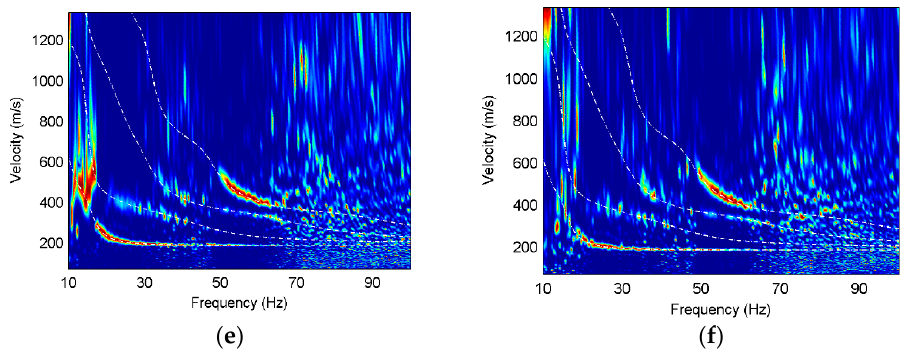
Figure 8. Dispersion images of noisy data of Model 1, where the white dashed lines are the theoretical dispersion curves and the red color represents the maximum energy. SNR of the left column is 2.8 and SNR of the right column is 1.7. ( a ) X component; ( b ) X component; ( c ) Z component; ( d ) Z component; ( e ) R y component; ( f ) R y component.